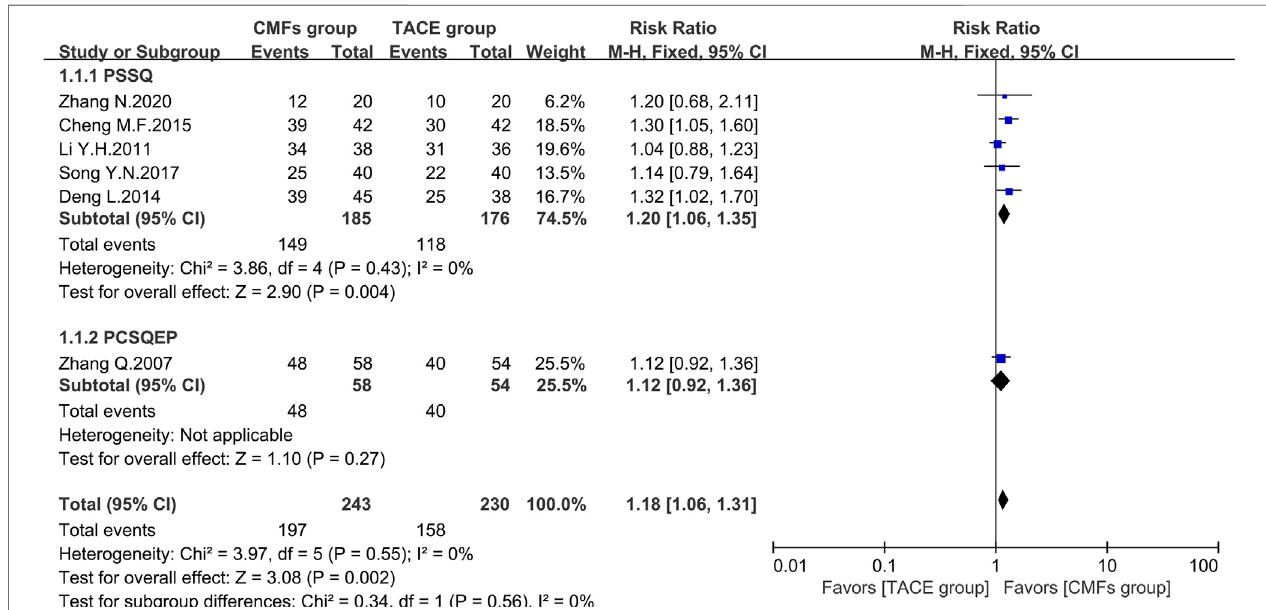
FIGURE 2 | Effect of CMFs group versus TACE group on 6-month survival, including a comparison between PSSQ and PCSQEP in the subgroup.